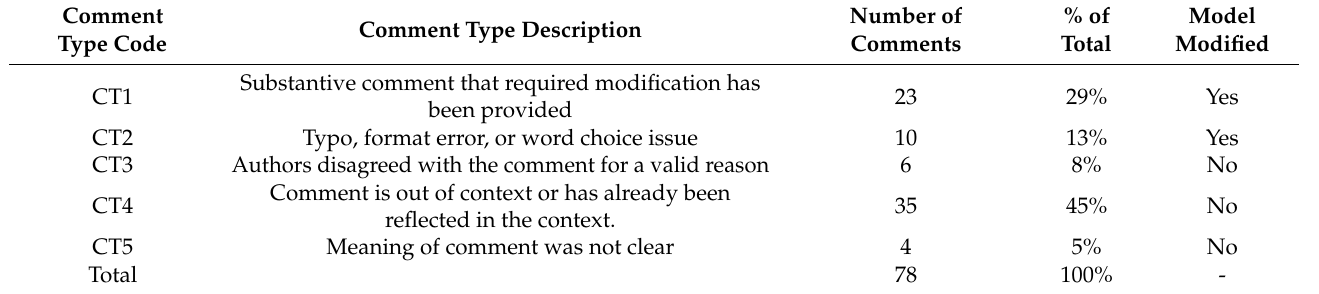
Table 2. Comments on constraints typology model and author